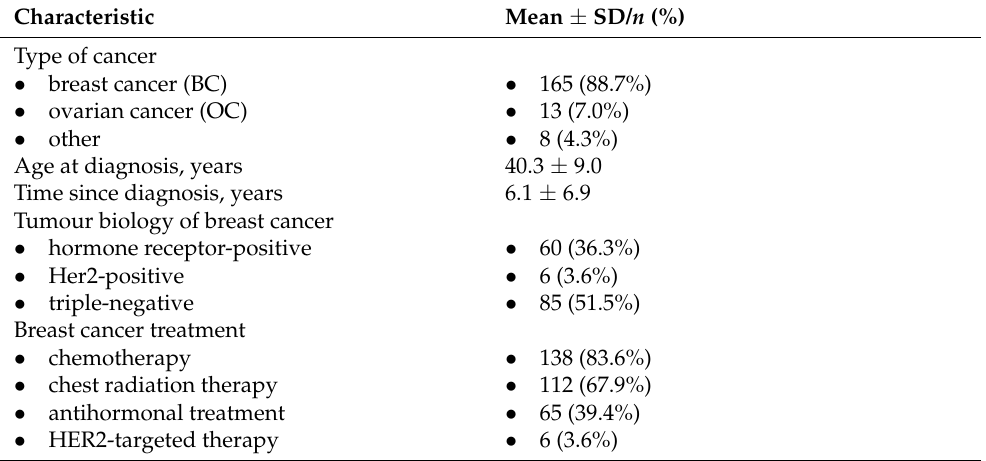
Table A1. Characteristics of participants with a prior history of cancer